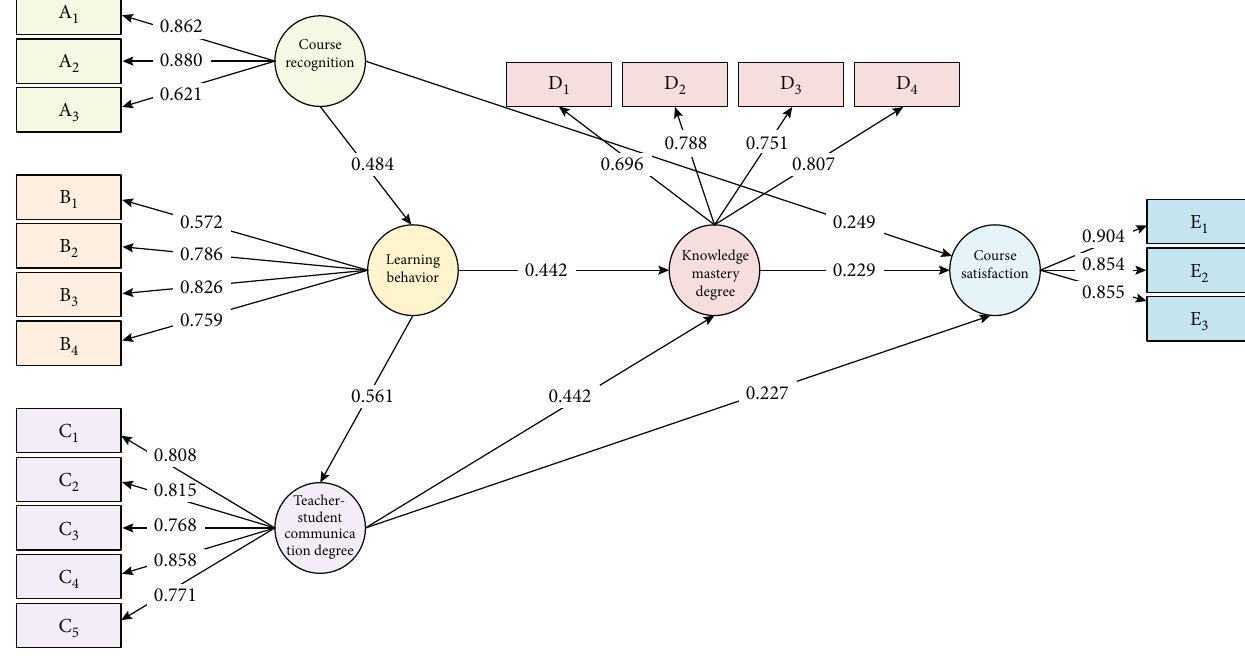
Figure. 9: Path coe ffi cient of the teaching model of health statistics. Table 2: Direct and indirect e ff ects of the